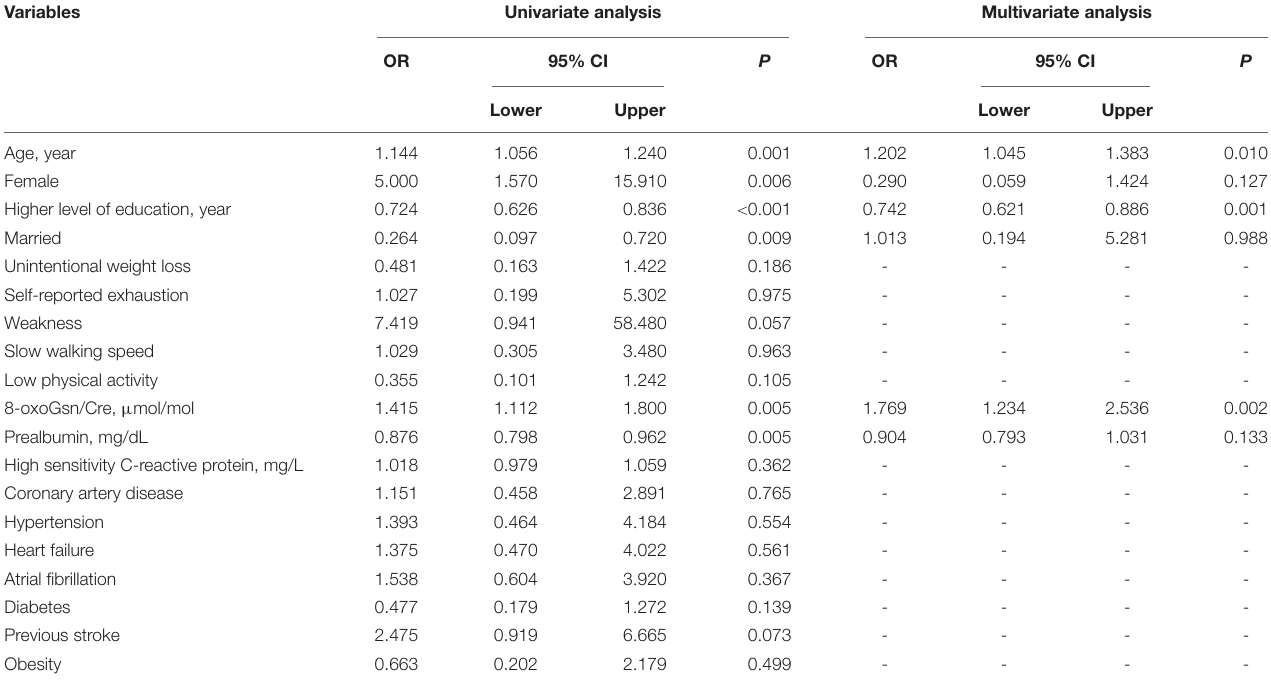
TABLE 2 | Univariate and multivariate logistic regression.